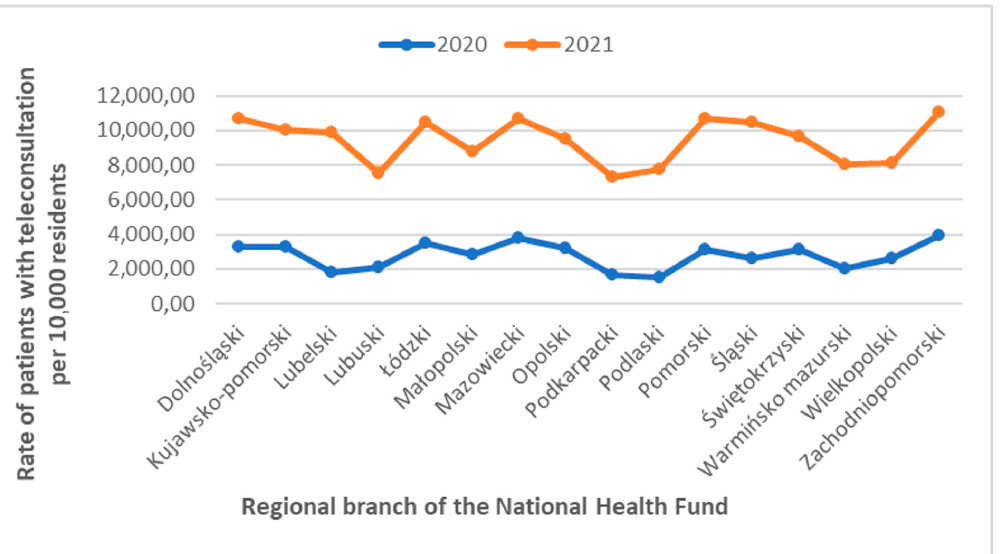
Figure 1. The diagram shows the growth of the primary care teleconsultations in voivodeships in 2020 and 2021.